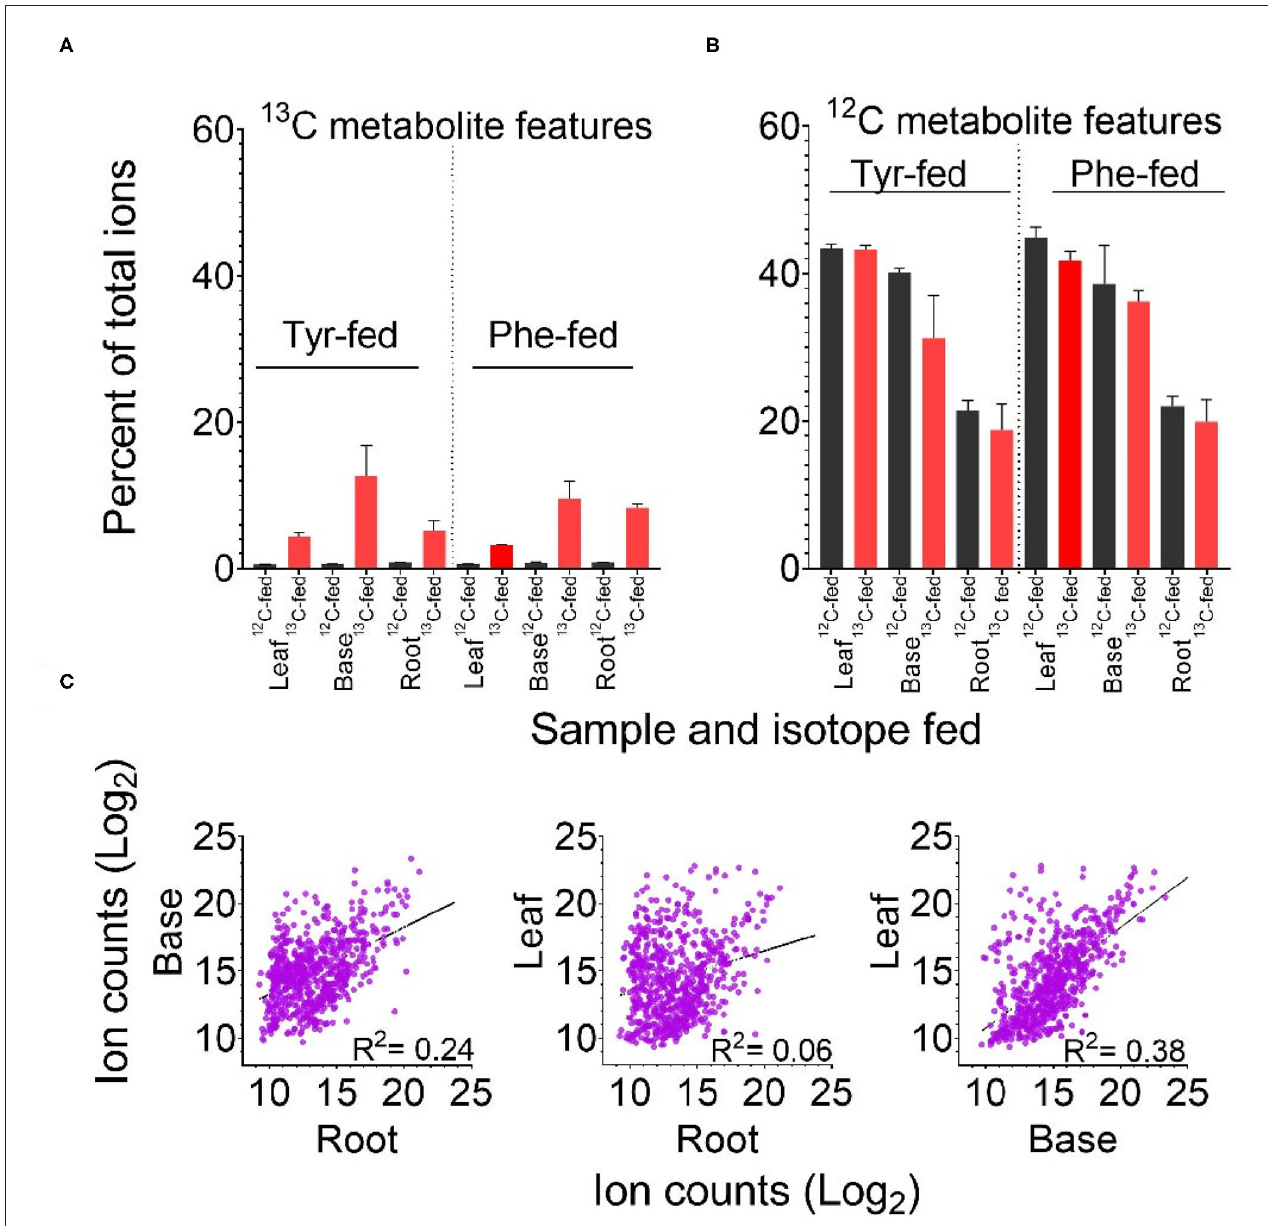
FIGURE 2 | Labeling of predicted Tyr- and Phe-derived metabolite features according to feeding regime and tissue. (A) Percent of the total ion count in metabolite features predicted to be derived from Tyr or Phe. (B) Percent of the total ion count in 13 C labeled features predicted to be derived from 13 C Tyr or 13 C Phe. Error bars in panels A and B indicate + /– SD of three biological replicates. (C) Comparison of log 2 ion counts in predicted Phe- and Tyr-derived metabolite features ( 12 C containing in 12 C Phe-fed and 12 C Tyr-fed tissue) across tissues. The broken line in each graph represents the best fit from linear regression and the correlation coefficient ( R 2 ) is